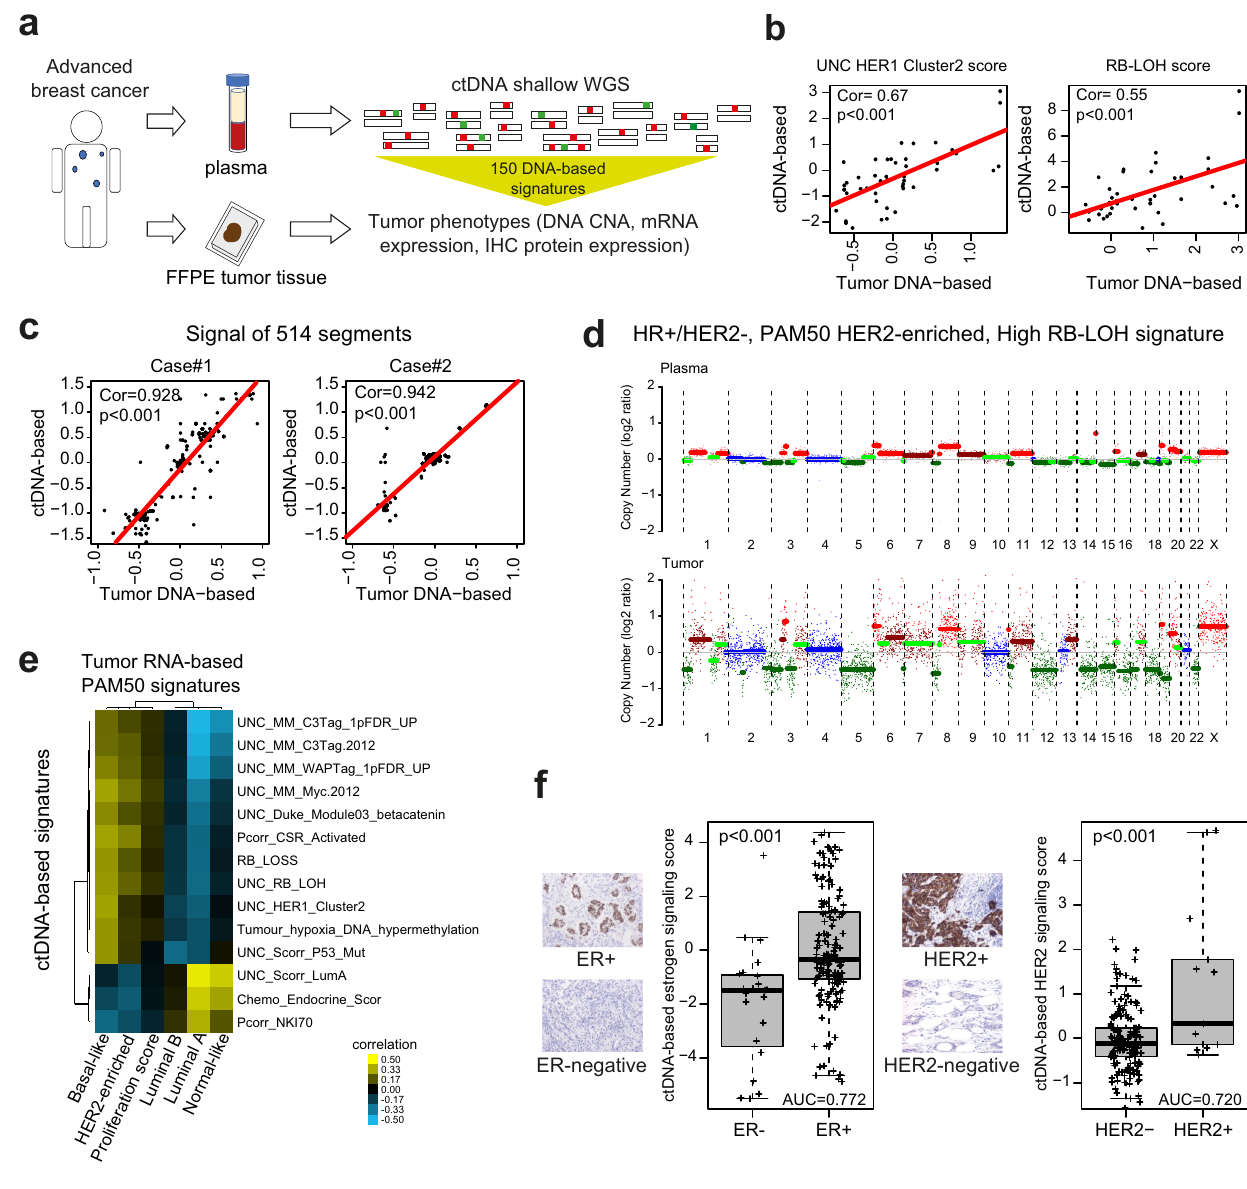
Fig. 2 | Circulating tumor DNA (ctDNA) in metastatic breast cancer. a Plasma sampleswereobtainedfrom207patients(174withHR+/HER2-,16HER2+,16TNBC, 1N/A). After puri fi cation of plasma cell-free DNA, shallow whole genome sequen- cing (shWGS) was performed. Using the ctDNA-based sequencing data from 514 DNA segments, 150 previously developed DNA copy number-based signatures 10 trackingavarietyofbiologicalprocesseswereappliedinpatientswithaTumorcell Fraction (TF) ≥ 3%. Individual scores for each signature were obtained. The com- plete names of the signatures, references and gene lists can be found in Supple- mentary Data 1. b Examples of correlation between the scores of the UNC_HER1_Cluster2 ( p < 0.001) and the RB-LOH ( p < 0.001) signatures when determinedinplasmaversustumortissue(thecorrelationsfortheothersignatures can be found in Supplementary Data 4). Of note, tissue samples were obtained at different timepoints than the plasma samples. c Examples of correlations of 514 DNA signals between plasma and tissue in two single patients (case#1 p < 0.001, case#2 p < 0.001).Correlation coef fi cients (Cor)and p in b and c were